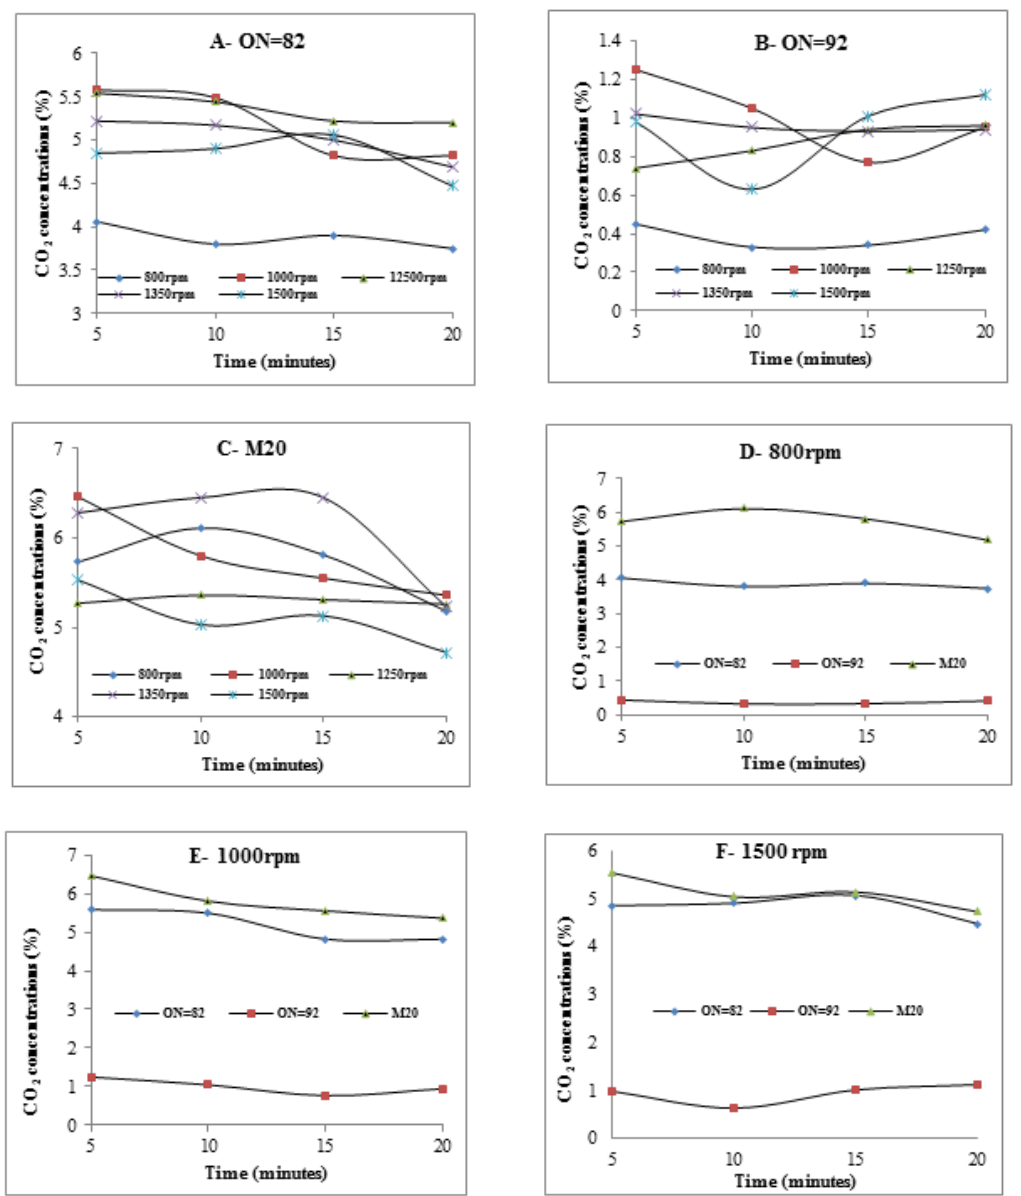
Fig. 5. the idling time effect on emitted CO